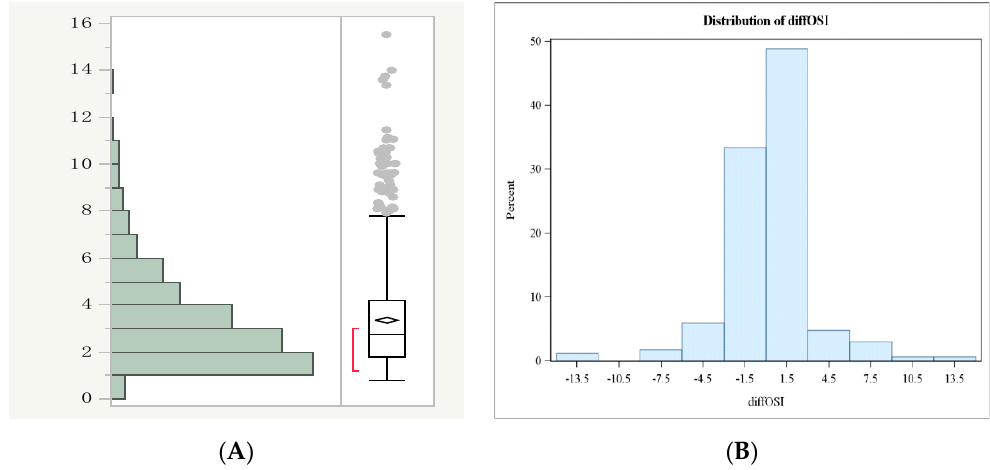
Figure 1. ( A ) Skewed distribution of OSI values (left) and the normal distribution after logarithmic conversion together with the diagram of quartiles (right). The cycles were subdivided into three subgroups according to the quartile of the OSI distribution: (a) the OSI < 0.17 (lower than the 25th quartile; low OSI; n = 623), (b) OSI 0.17–1.59 (between the 25th and the 75th quartile; the intermediate OSI; n = 1846), and (c) the OSI > 0.59 (higher than 75th quartile; high OSI, n = 884). ( B ) The distribution of the difference in the OSI (diffOSI) observed in patients who underwent two consecutive COS cycles changing the COS regimen from GnRH-agonist long protocol to GnRH-antagonist protocol (or vice versa). Only 18% of the patients showed a diffOSI > 1.5 between one COS protocol and the other. Table 3. Relationship between the OSI, pregnancy rate (PR / ET), and clinical pregnancy rate (CPR / ET). The PR / ET and CPR / ET were significantly higher ( p < 0.0001) in cycles with a high OSI ( > 75 ◦ quartile) than in cycles with a low ( < 25 ◦ quartile) or an intermediate (25 ◦ –75 ◦ quartile) OSI, despite the comparable mean patients’ age. * p < 0.0001 vs. other quartiles. PR / ET (%) CPR / ET